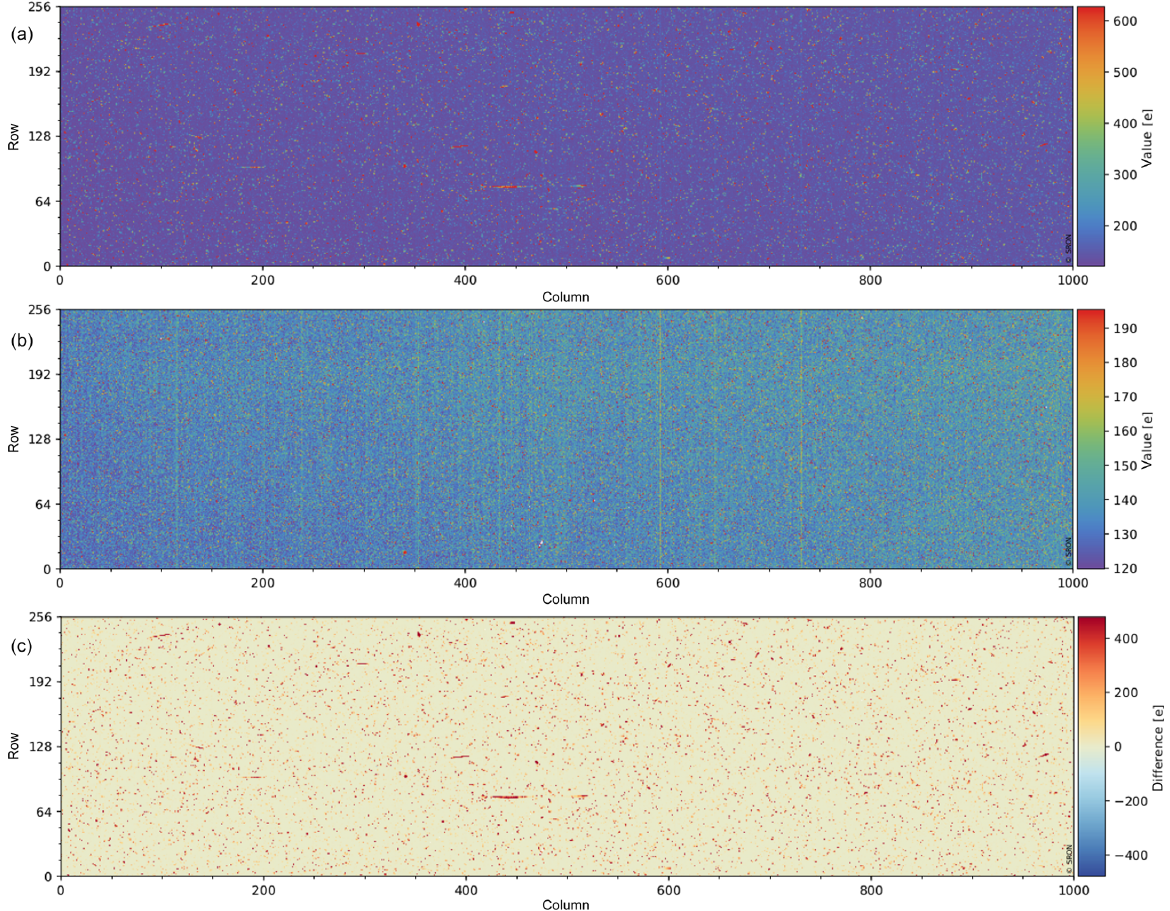
Figure 10. The noise of the SWIR detector measured during orbit 2707 to 2722 for an exposure time of 538.3ms with the FMM closed, showing the noise calculated as a mean (a) , median (b) , and the difference between the two (c)